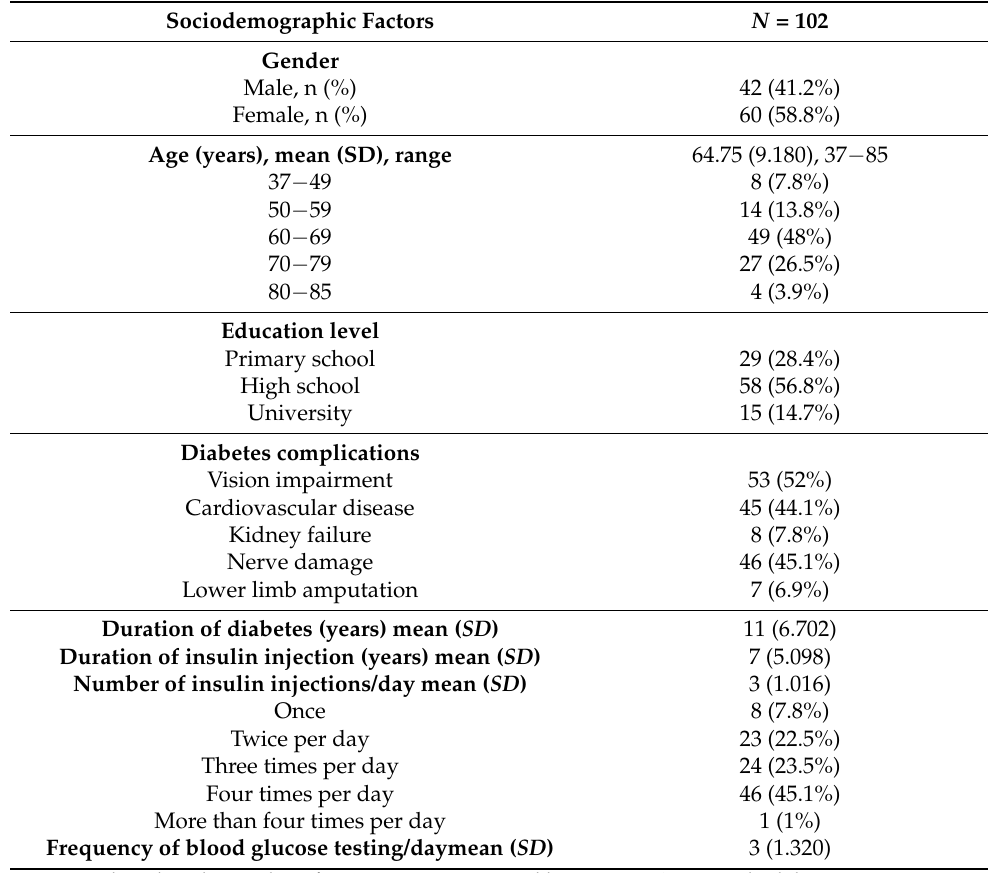
Table 1. Sociodemographic characteristics of the sample and descriptive statistics of the study